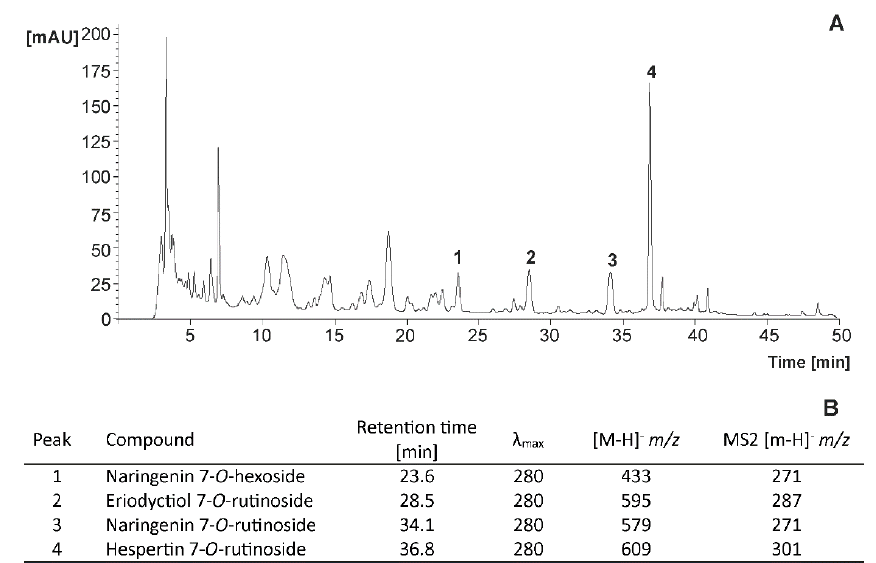
Figure 3. Representative chromatogram of the maqui–citrus juices recorded at 280 nm ( A ) and identity of the flavanones identified ( B of the flavanones identified ( B ).